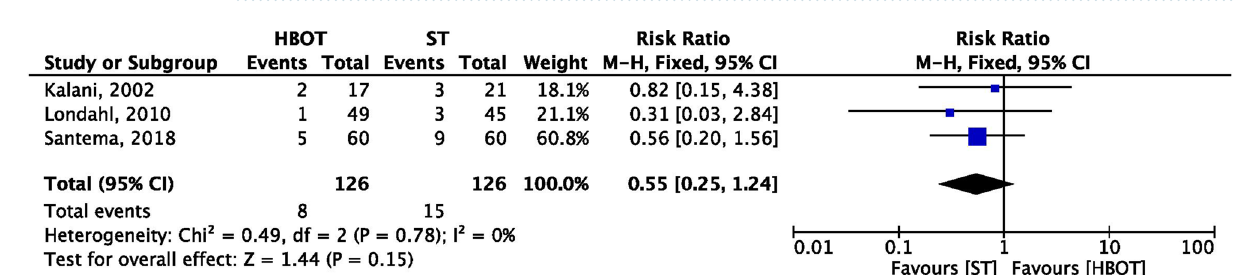
Figure 8. Forest plot of comparison: HBOT versus ST, Outcome: Adverse Event.